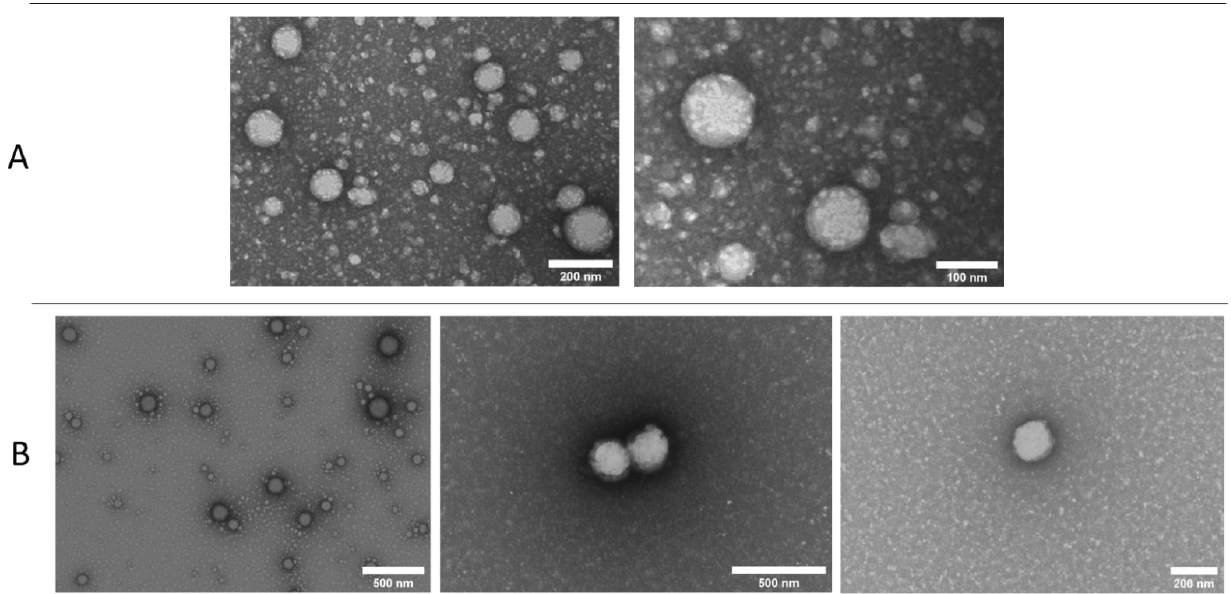
Figure 3. TEM picture of lipomers after negative staining with uranyl acetate. Panel ( A ) corresponds to non-FD lipomers (image reproduced from [7], MDPI, 2021). Panel ( B ) corresponds to FD lipomers.